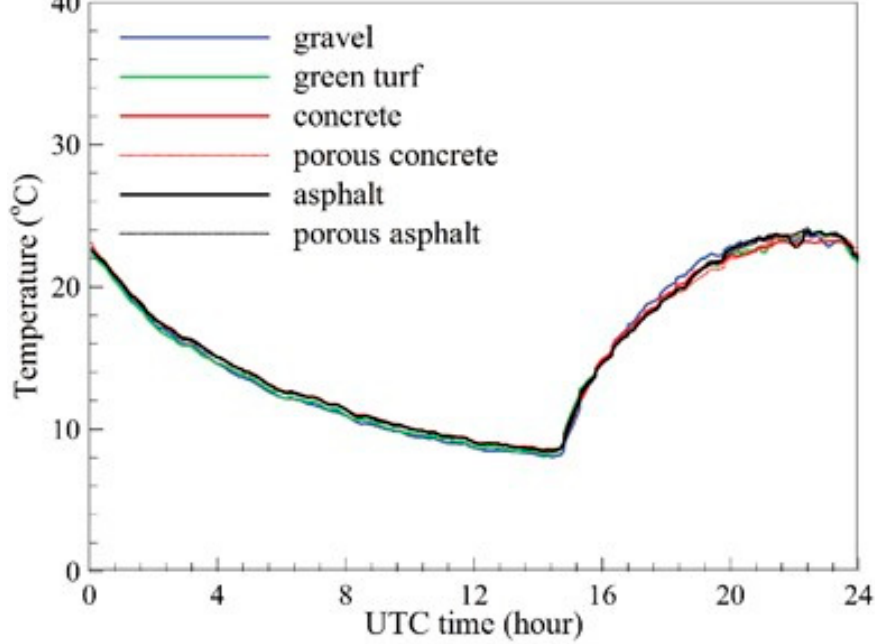
Figure 6. Air temperature at 5 feet over six ground cover materials [96].